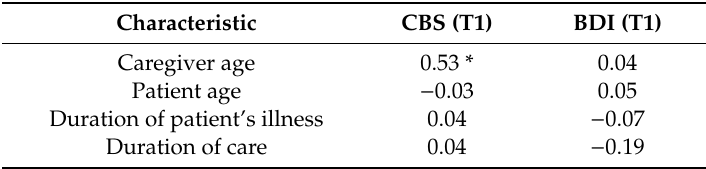
Table 7. Pearson’s linear correlation coe ffi cient (r) of selected characteristics of care undertaken with the results of CBS and BDI scales at the